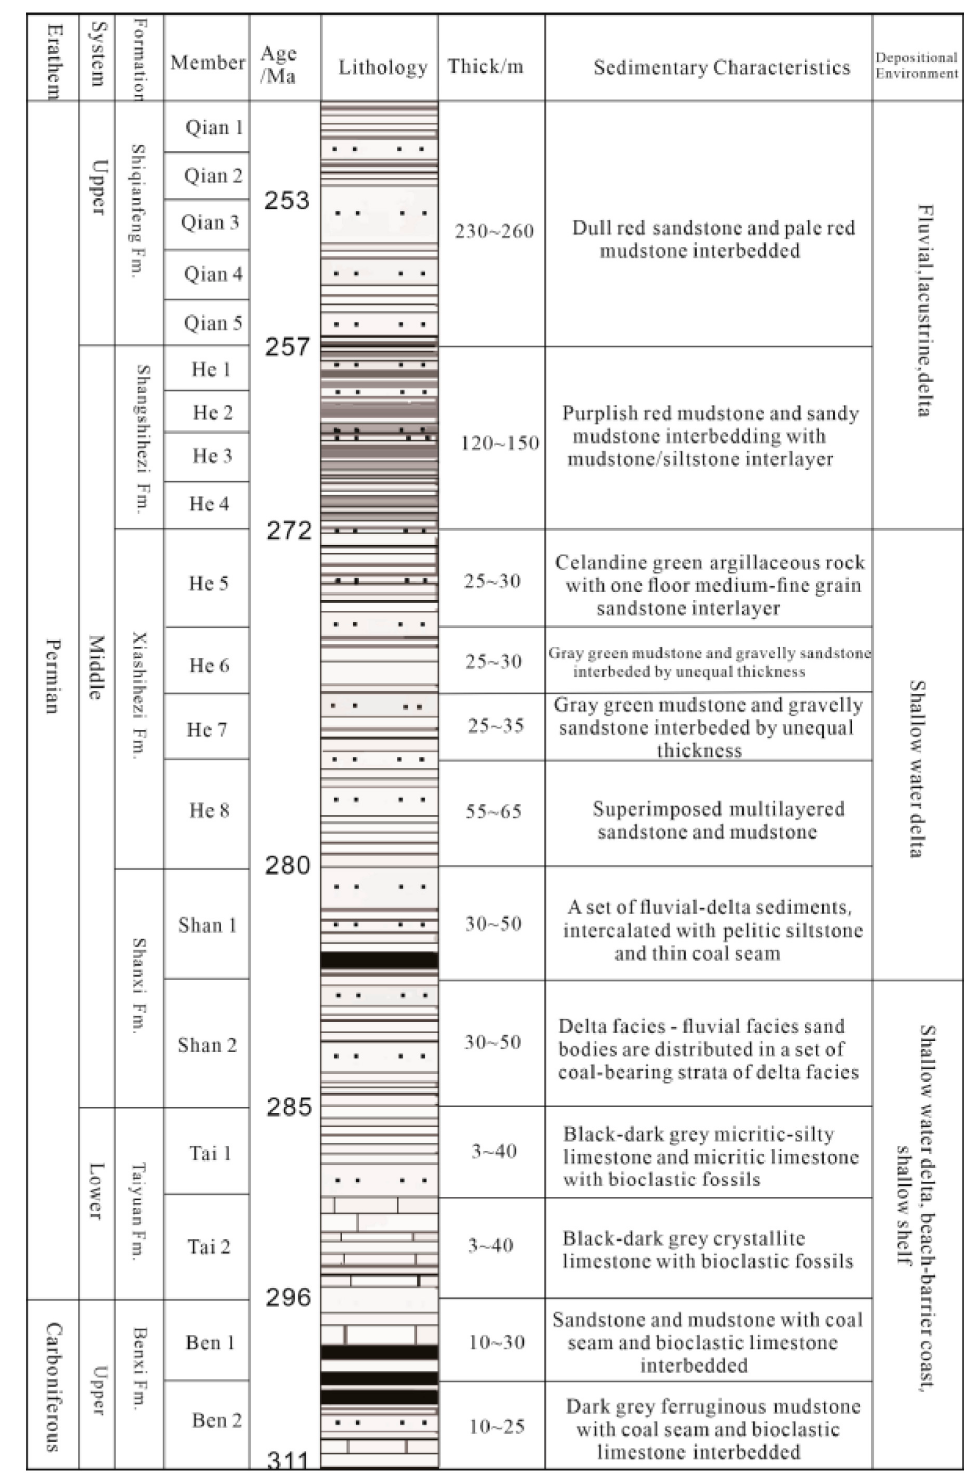
Figure 1. A comprehensive stratigraphic histogram of Upper Paleozoic strata in the Ordos basin.